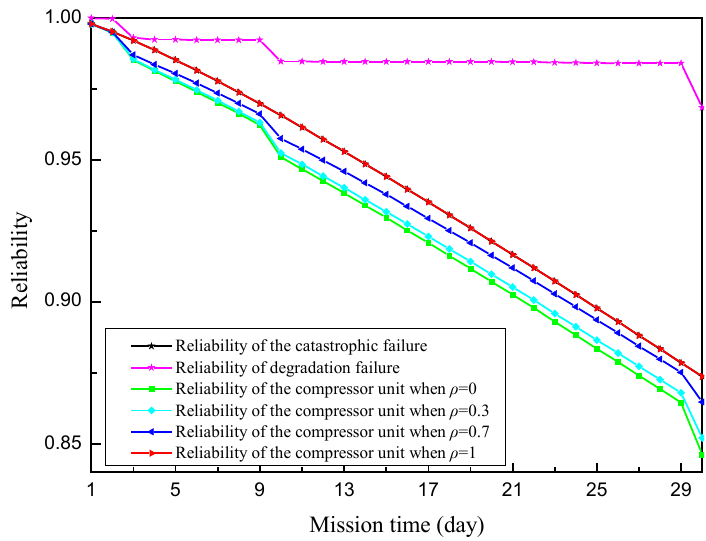
Figure 10. The change process of the reliability of the compressor unit.